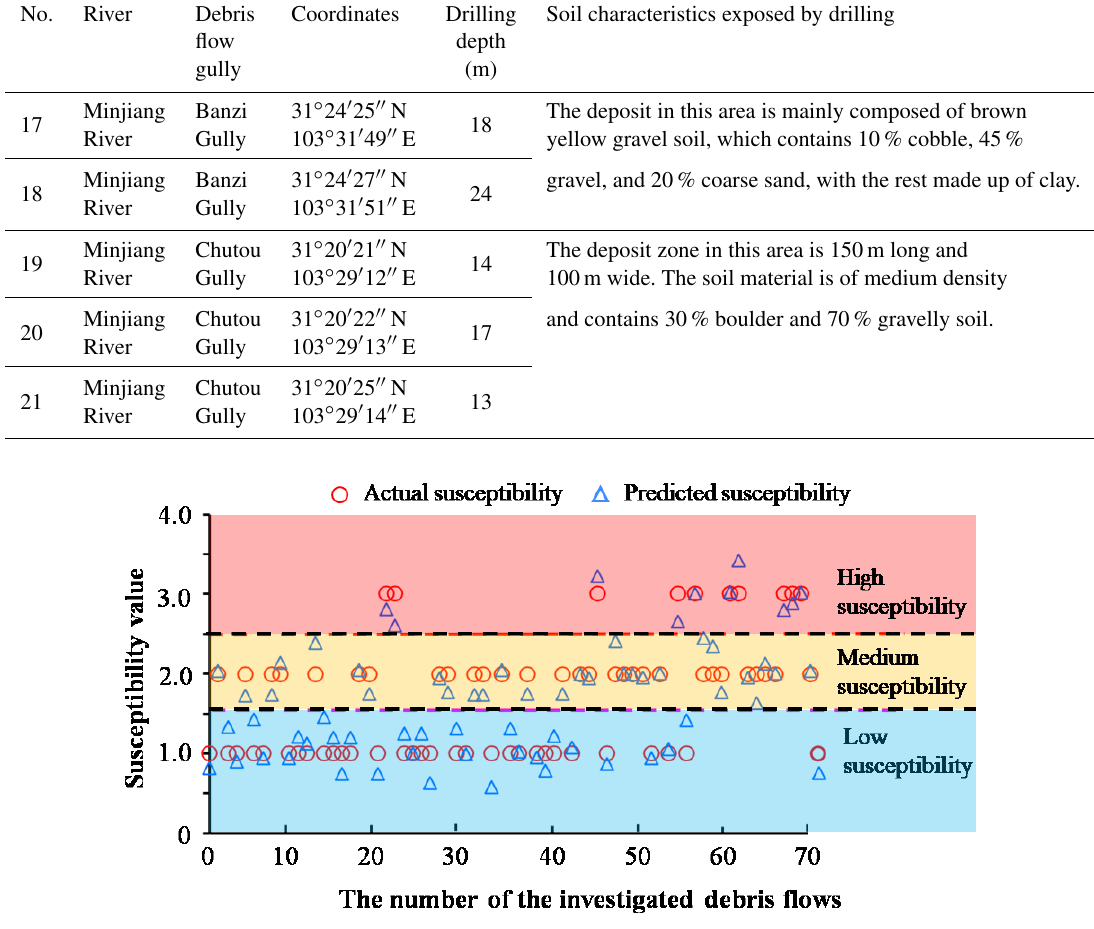
Figure 4. Typical characteristics of the Danba section in the upper reaches of the Dadu River.